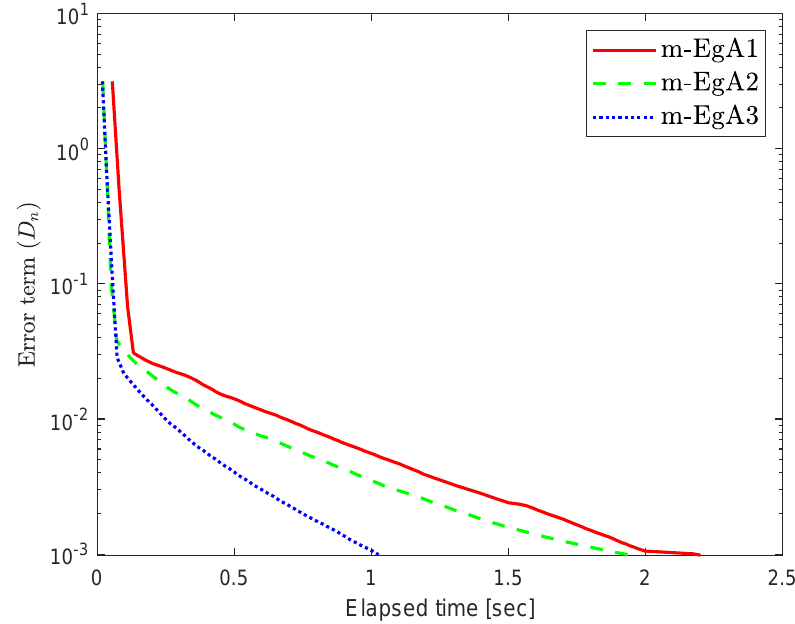
Figure 4. Numerical behaviour of Algorithm 1 compared to Algorithm 1 in [30] and Algorithm 2 in [30] for Example 1, when m =